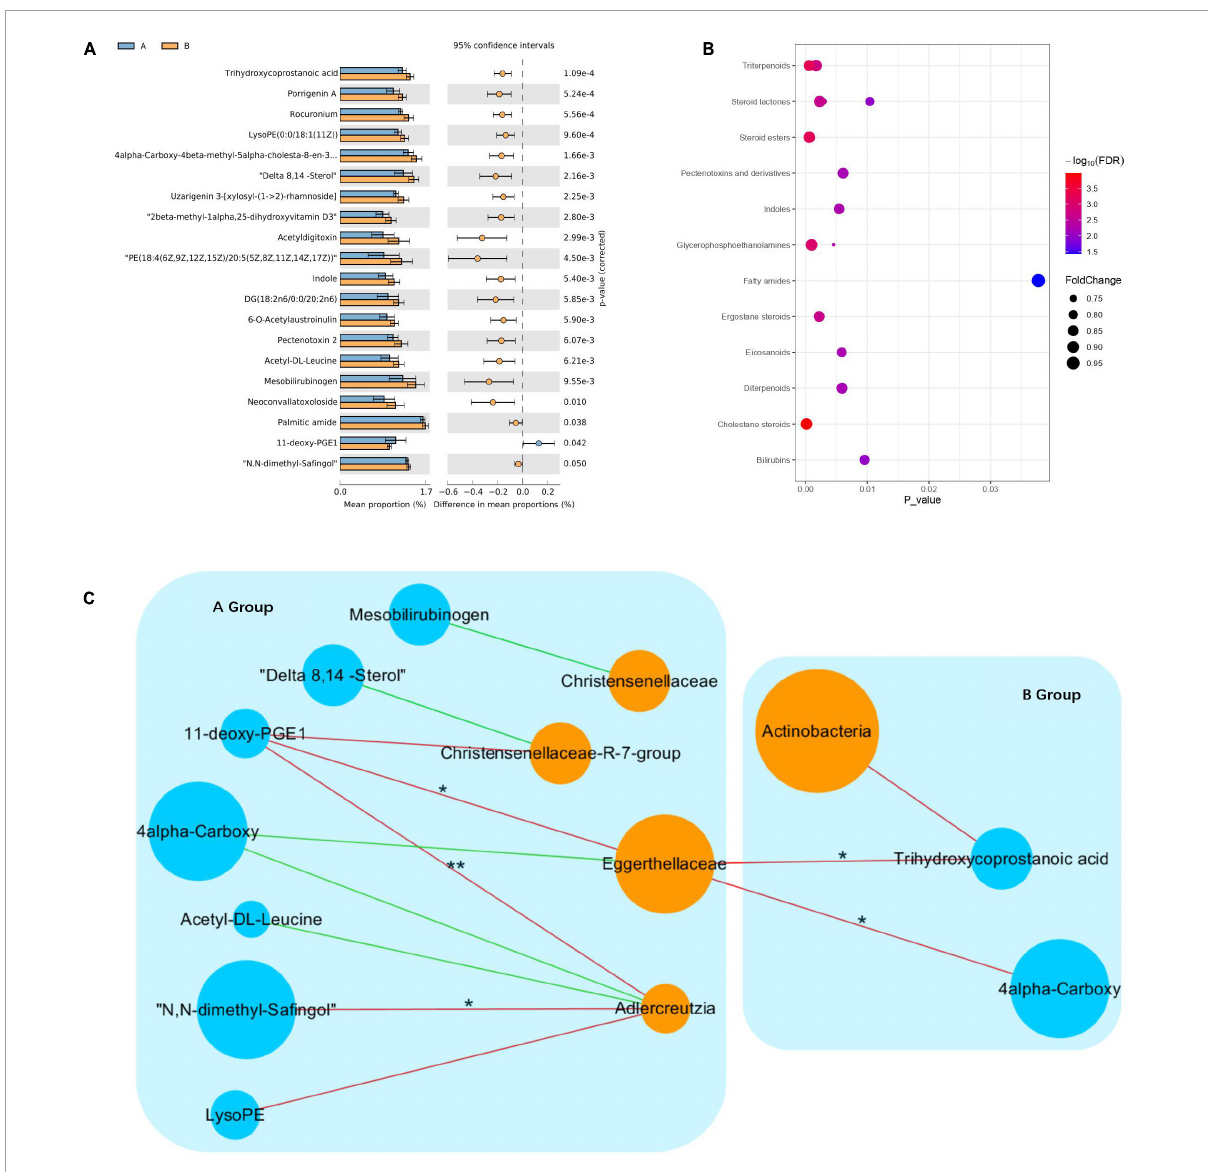
FIGURE3 Changes in metabolic signatures between responder and non-responder groups at baseline. (A) Histogram based on differentially abundant metabolites between the responder and non-responder groups, determined by Welch’s t -test. (B) Pathway enrichment analysis of differentially abundant metabolites. Lipid metabolism is the predominant metabolic pathway. (C) Interaction networks among differential species and metabolites; node size indicates abundance, different colors represent metabolites (blue) and species (orange), negative correlations are shown as red lines, positive correlations are shown as green lines (Spearman correlations, * p < 0.05, ** p <